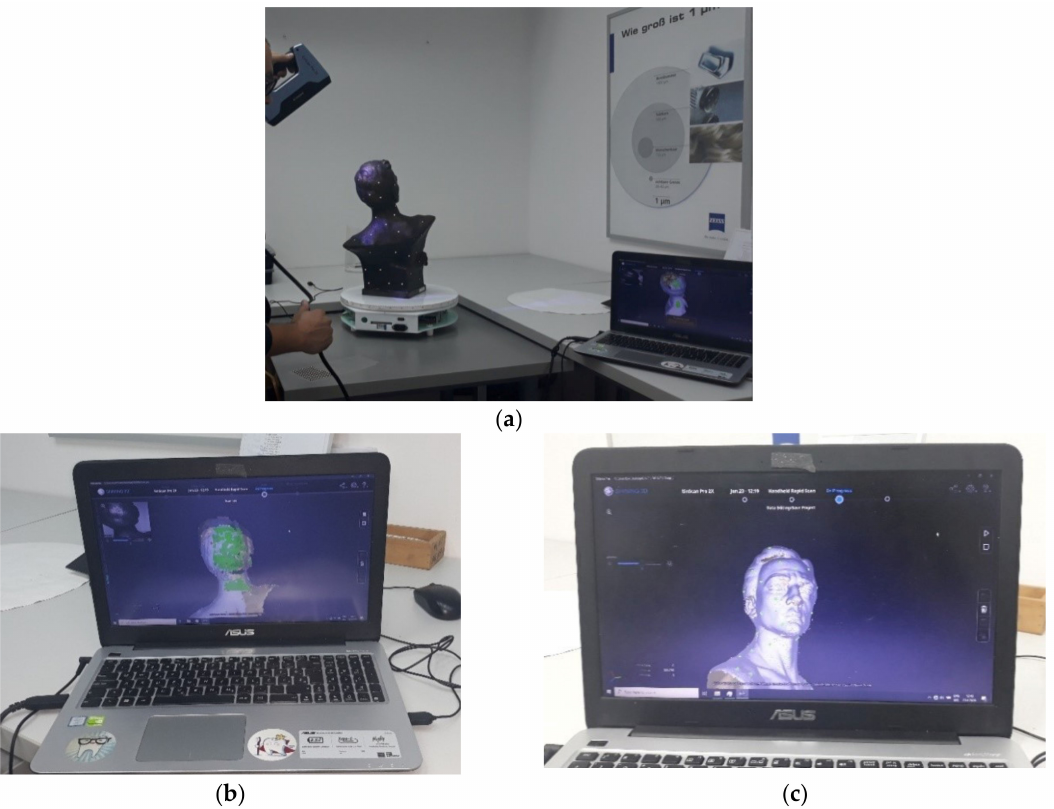
Figure 6. Real-time data observation by EinScan 2X Pro scanner: ( a ) Collected a point cloud through 3D scanning procedure; ( b ) during processing; ( c ) finished point cloud.